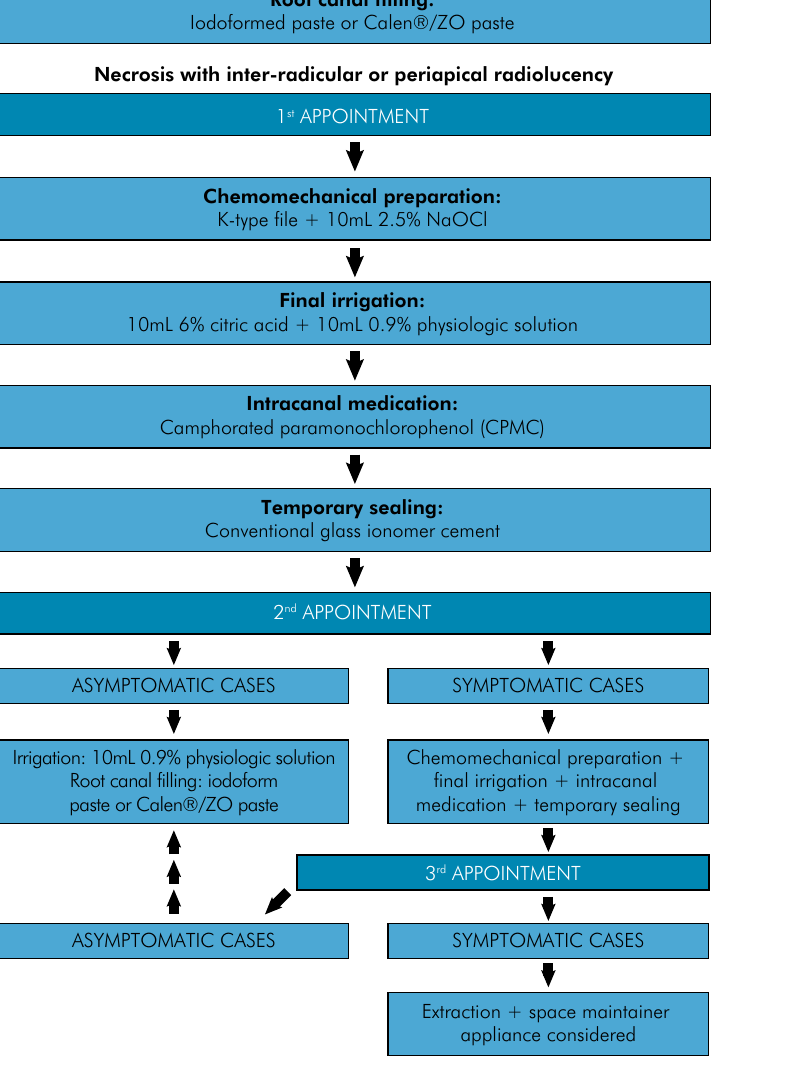
Figure 1. Protocol for pulpectomy in primary teeth with smear layer